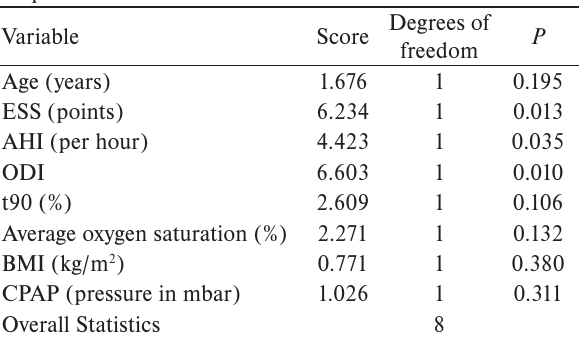
Table 4. Logistic regression – prediction of the adherence after ten years of CPAP treatment (variables not in the